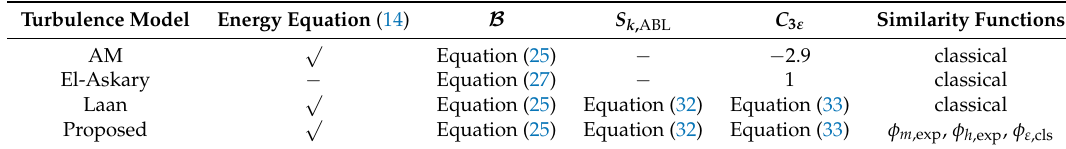
Table 1. Summary of turbulence models investigated for stable conditions, where “ − ” represents that √ the corresponding term is absence in the model, “ ” represents that the energy equation is solved, and “classical” denotes standards for the classical similarity